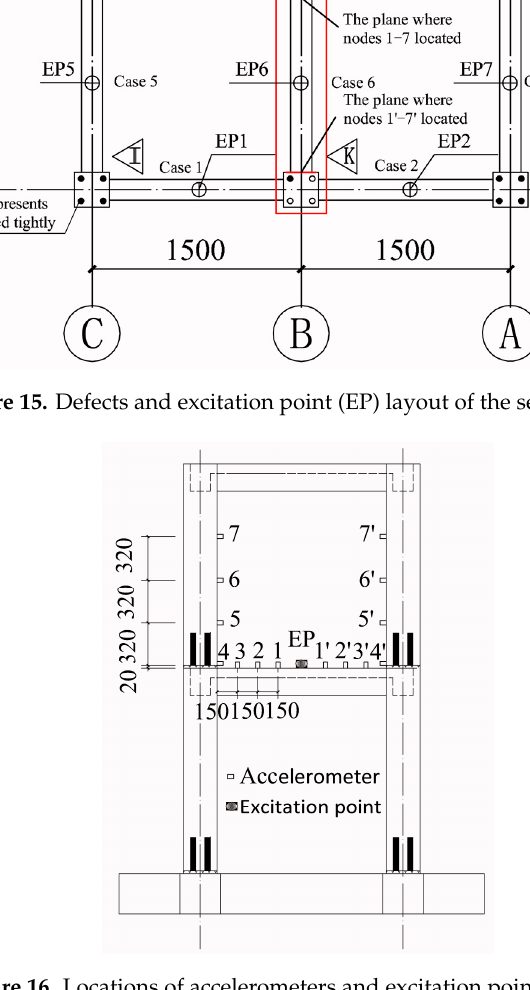
Figure 16. Locations of accelerometers and excitation point in case 6.